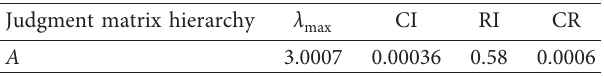
Table 7: Consistency test of the judgment